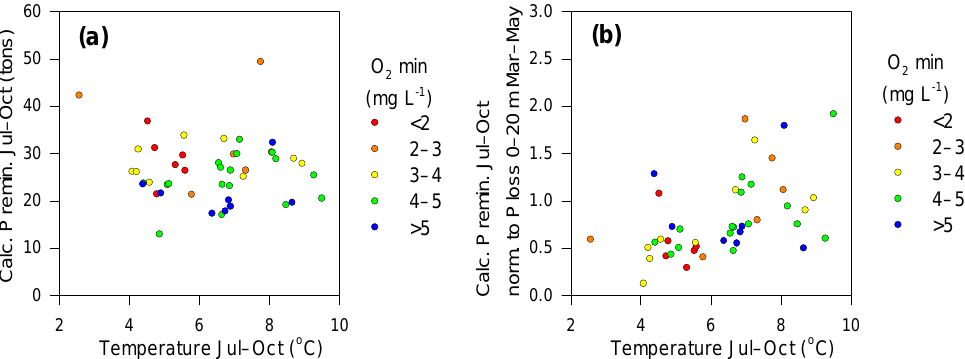
Figure 10. (a) Annual oxygen consumption for July–October 1969–2015 (1975 and 2011 excluded) recalculated to theoretical deep-water P remineralization, as a function of temperature. The data set is colour-coded according to the minimum oxygen concentration for July– October ( y = 28 . 3 − 0 . 31 x , r 2 = 0.006, p = 0.60). (b) As in (a) but with theoretical P remineralization normalized to P loss from the 0 to 20m layer in March–May ( y = − 0 . 030 + 0 . 13 x , r 2 = 0.25, p <